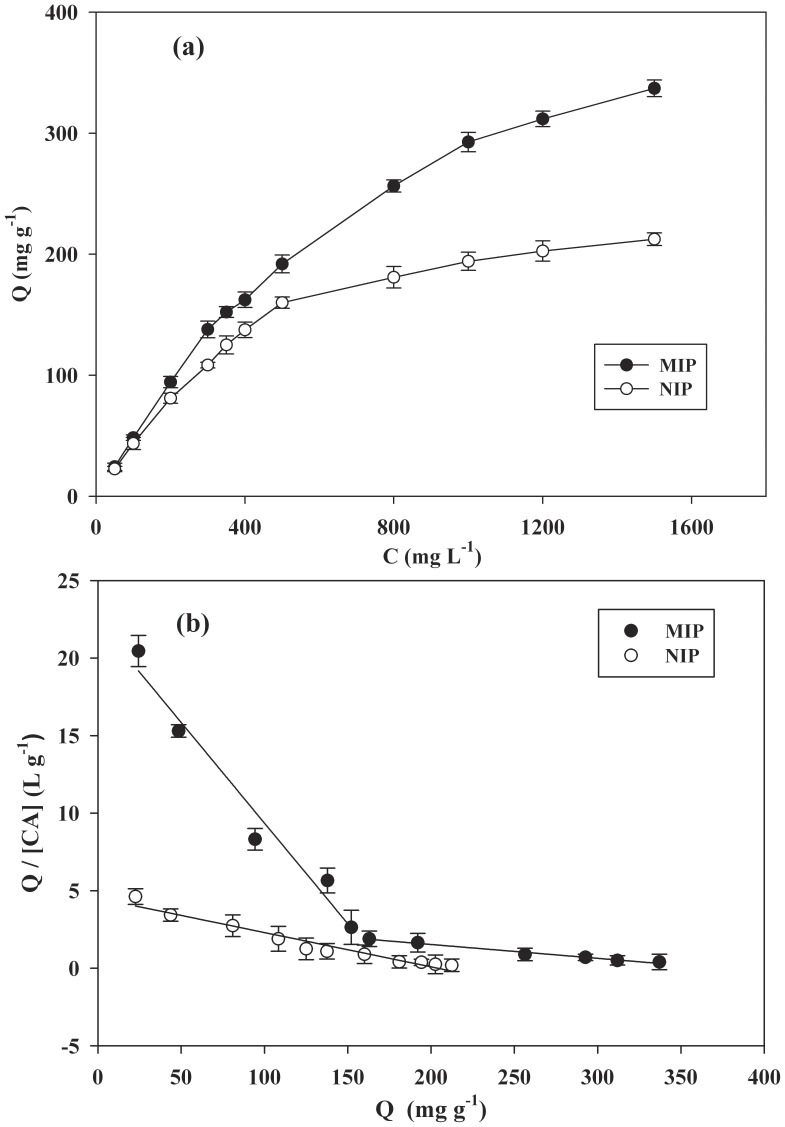
Adsorption isotherms (a) and Scatchard plots (b) of MIP and NIP (mean ±SD, n = 3).